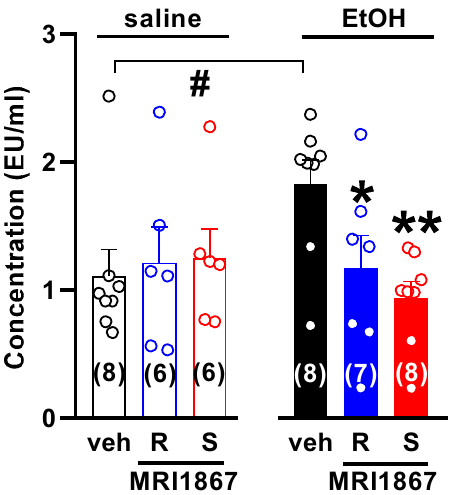
Figure 5. The iNOS inhibitor R -MRI-1867 decreases serum endotoxin level in acutely alcohol-intoxicated mice. Mice received S -MRI-1867 10 mg/kg (S) or R -MRI-1867 10 mg/kg (R) or vehicle (veh) by oral gavage (time 0), followed by intragastric administration of 6 g/kg ethanol (30% w / v ; EtOH) or saline at 30 min. Endotoxin was measured in the serum obtained from the portal vein 1 h after the acute alcohol challenge. Results are expressed as mean ± s.e.m. * p < 0.05, ** p < 0.01, compared with vehicle in alcohol-treated group (one-way ANOVA followed by Dunnett’s post hoc test), # p < 0.05, compared with saline-treated mice.